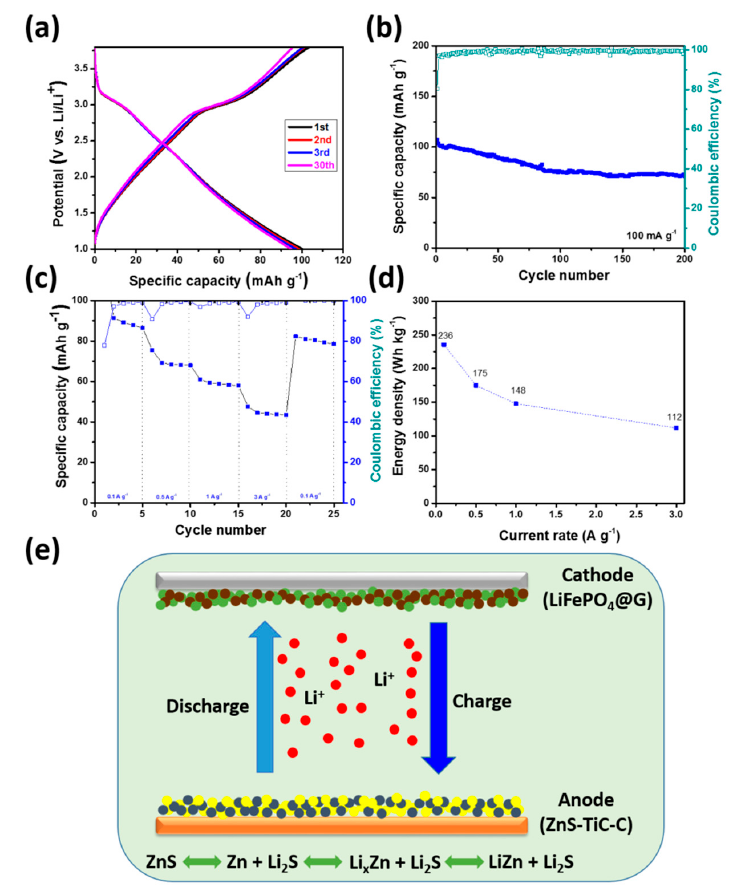
Figure 8. Performance of the full cell using ZnS(80%)-TiC-C as an anode and LiFePO 4 -G as a cathode: (a) galvanostatic charge/discharge profiles obtained at 0.1 A g − 1 over the voltage range of 1–3.8 V; (b) cyclic performance at 0.1 A g − 1 ; (c) rate capability at different current densities ranging from 0.1 to 3 A g − 1 ; (d) energy density at different current rates of the ZnS-TiC-C//LFP-G full cell; and (e) schematic of the ZnS–TiC-C//LFP-G full cell.